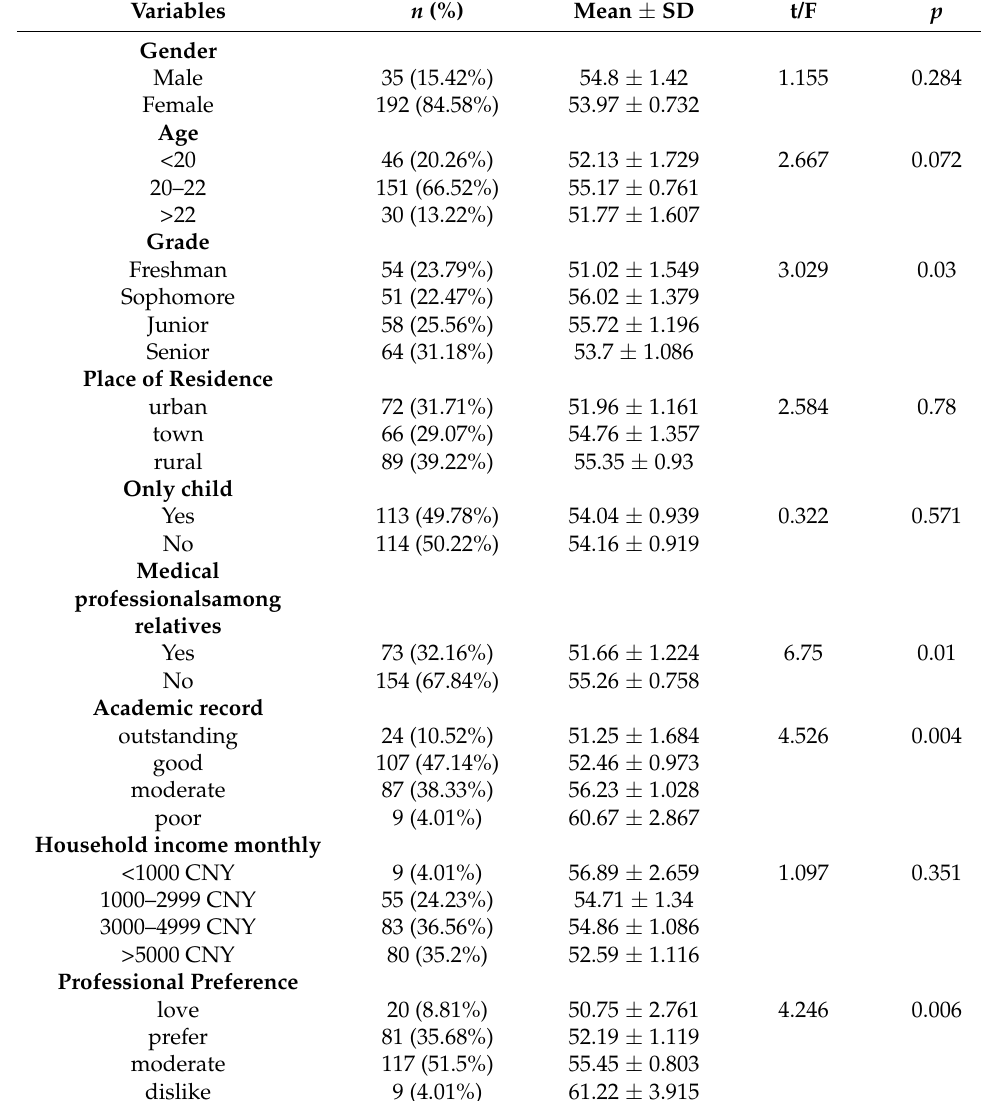
Table 1. Distribution of the learning burnout according to demographic characteristic groups ( n =